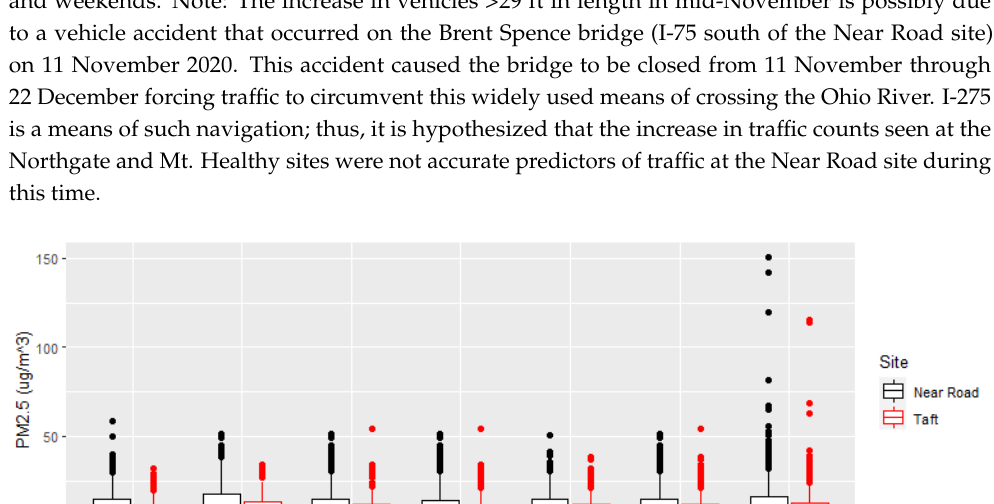
Figure 7. Predicted daily traffic counts at the Near Road site for each classification type (total traffic count, 7–29 ft, and >29 ft). The two trends are indicative of traffic volume variation between weekdays and weekends. Note: The increase in vehicles >29 ft in length in mid-November is possibly due